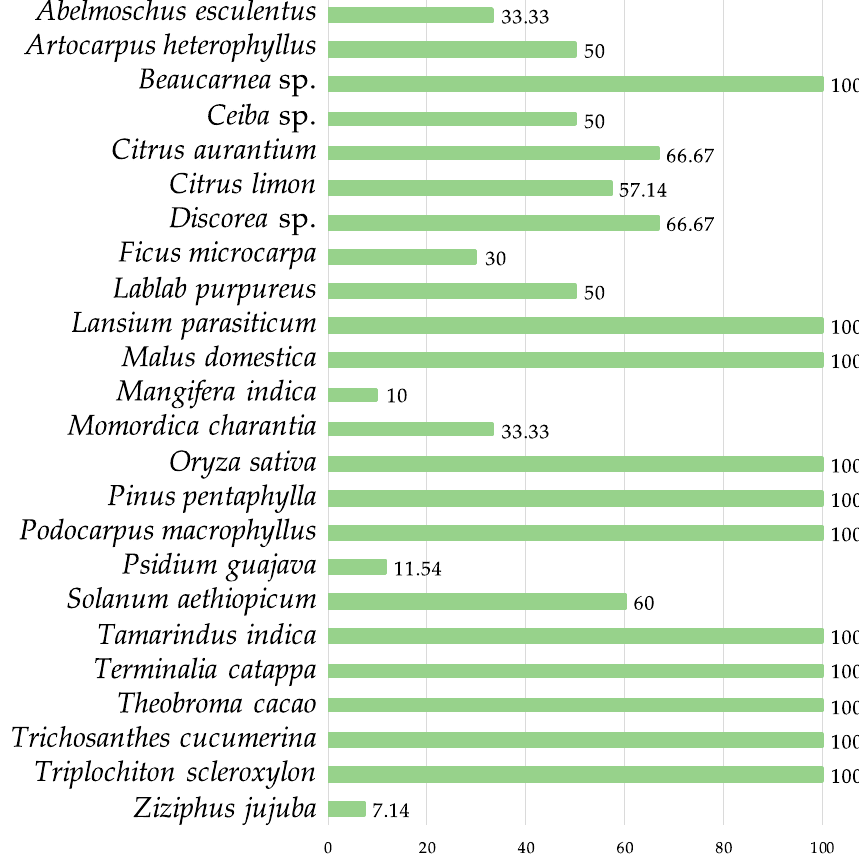
Figure 3. Percentage of infestation of the plant material for the different species examined. About 50% of the incoming goods in which harmful pests were detected came from Asian countries. Among these, Bangladesh had the highest number of infested plant materials (47%). Percentages higher than 20% were reached by Ethiopia and Ghana among the African countries and by Argentina, Uruguay, and El Salvador in the South American countries (Figure